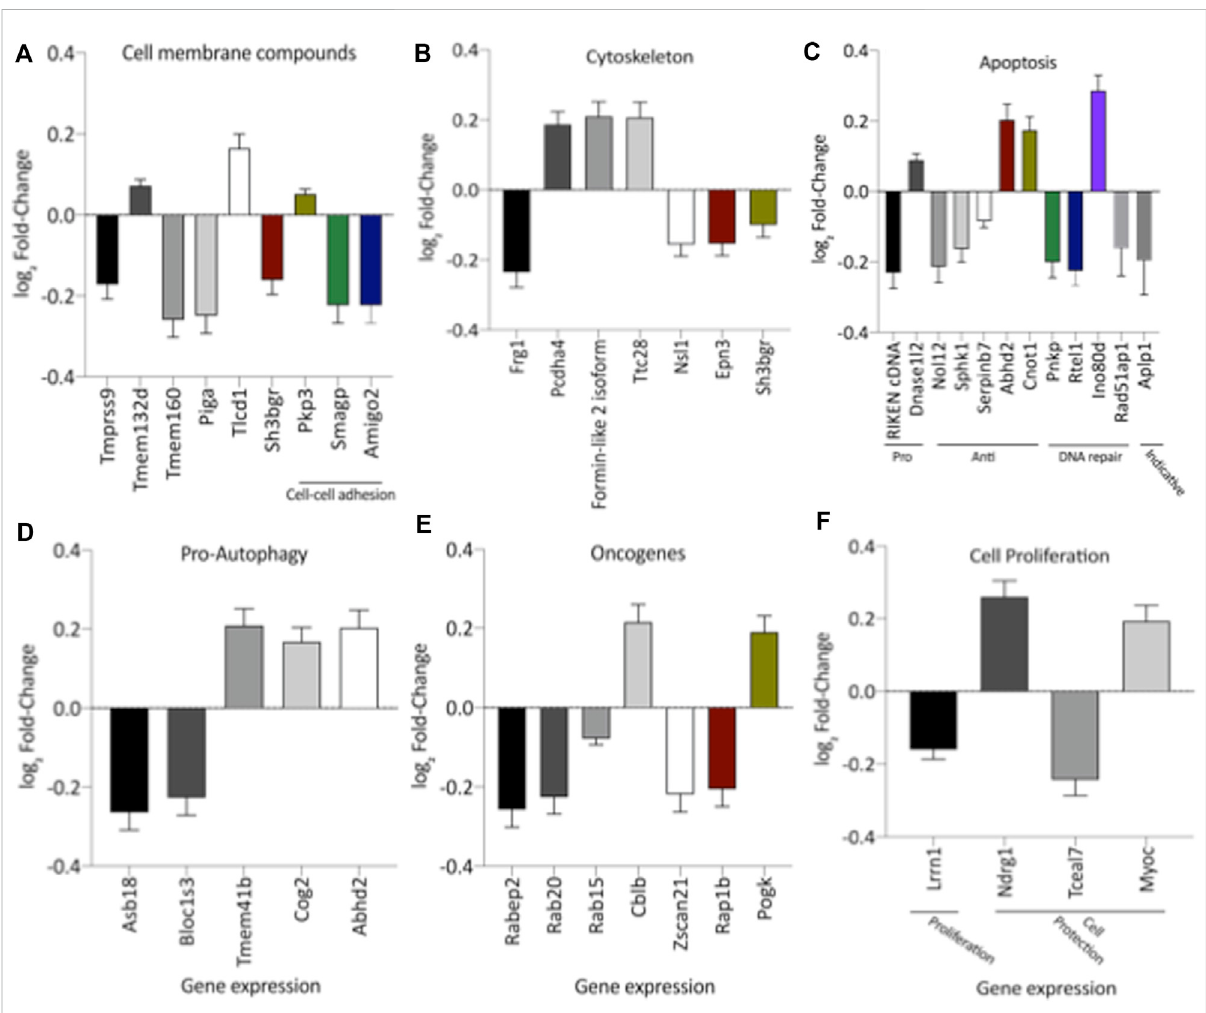
FIGURE 5 Expression of genes signi fi cantly altered, grouped by their participation in cell membrane compounds (A) , cytoskeleton (B) , apoptosis (C) , autophagy (D) , oncogenes (E) , and cell proliferation (F) . The analysis was performed based on pertinent literature on aging and cardiac disease (the gene's abbreviations and references are found in Supplementary Table S1). The results were expressed as mean ±